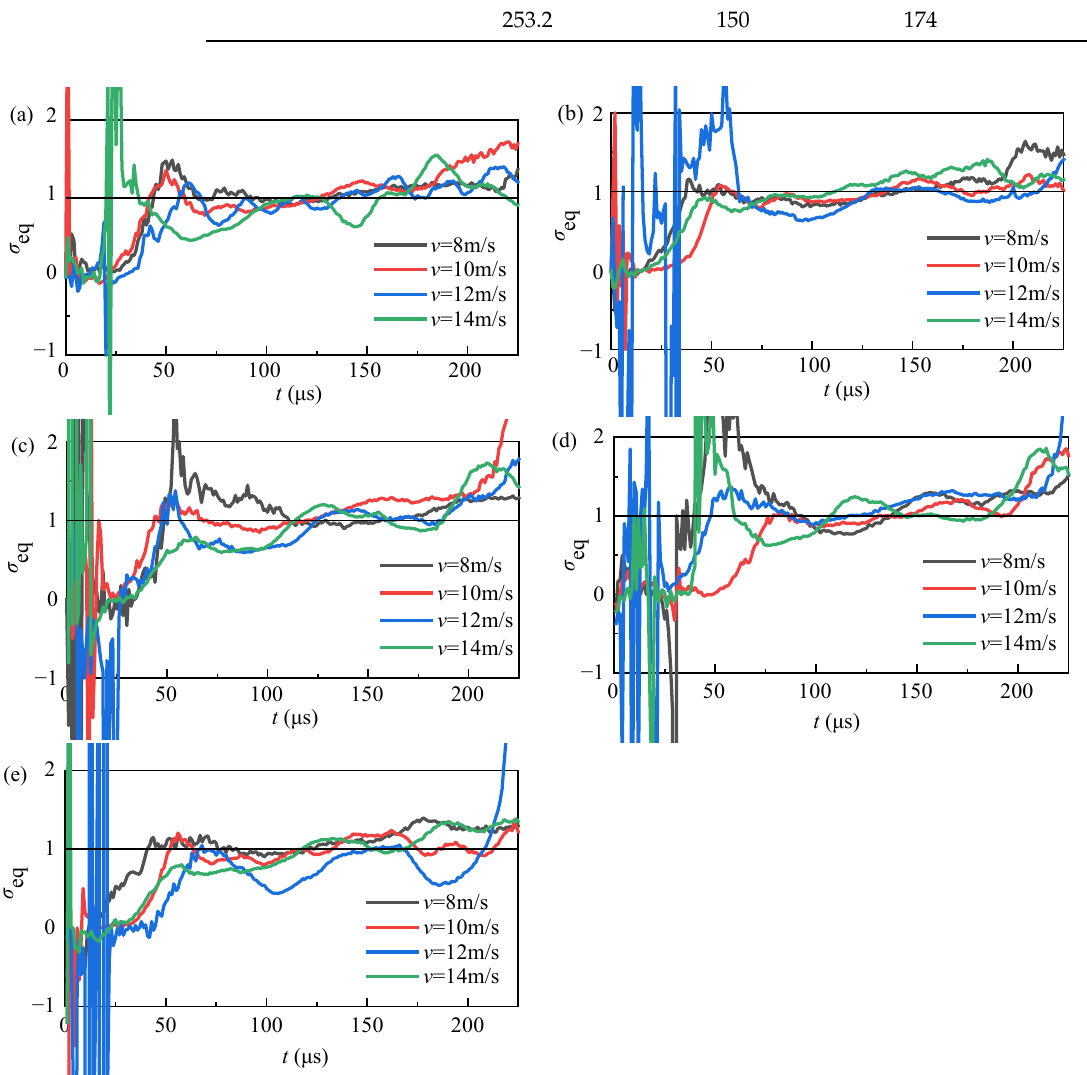
Figure 3. Stress equilibrium factor curve with different strain rates includes length–diameter ratio of 0.6 ( a ), 0.8 ( b ), 1.0 ( c ), 1.2 ( d ), and 1.4 ( e ). 0.6 ( a ), 0.8 ( b ), 1.0 ( c ), 1.2 ( d ), and 1.4 ( e Under the same impact load, the granite specimens with a length–diameter ratio from 0.8 to 1.4 are in the stress equilibrium period of 46–151 μs, 36–174 μs, 108–185 μs, 82–148 μs, and 75–138 μs, respectively. By comparison, the waveform of stress balance factor with